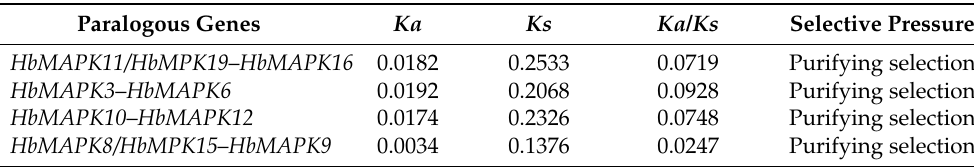
Ka , nonsynonymous substitution rate; Ks , synonymous substitution rate. Table 4. Tajima relative rate tests of MPK gene pairs in rubber tree. a Table 4. Tajima relative rate tests of MPK gene pairs in rubber tree. a Testing